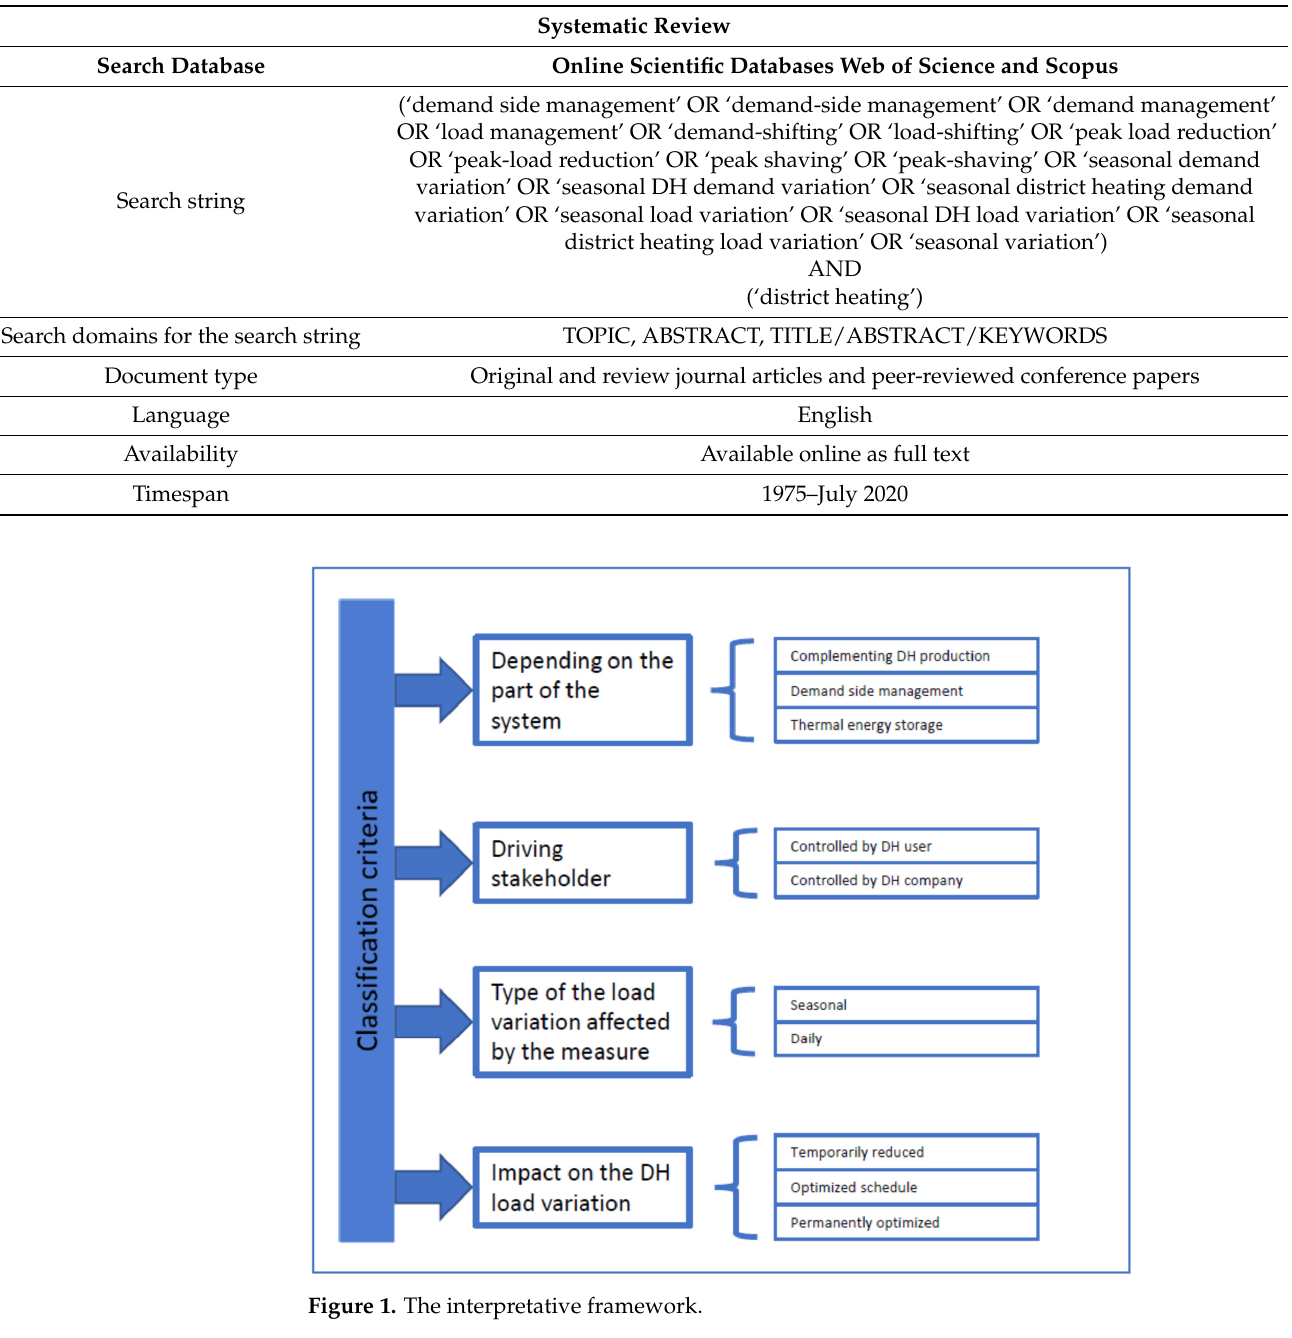
Table 1. The search strings and inclusion and exclusion criteria applied for the systematic review.